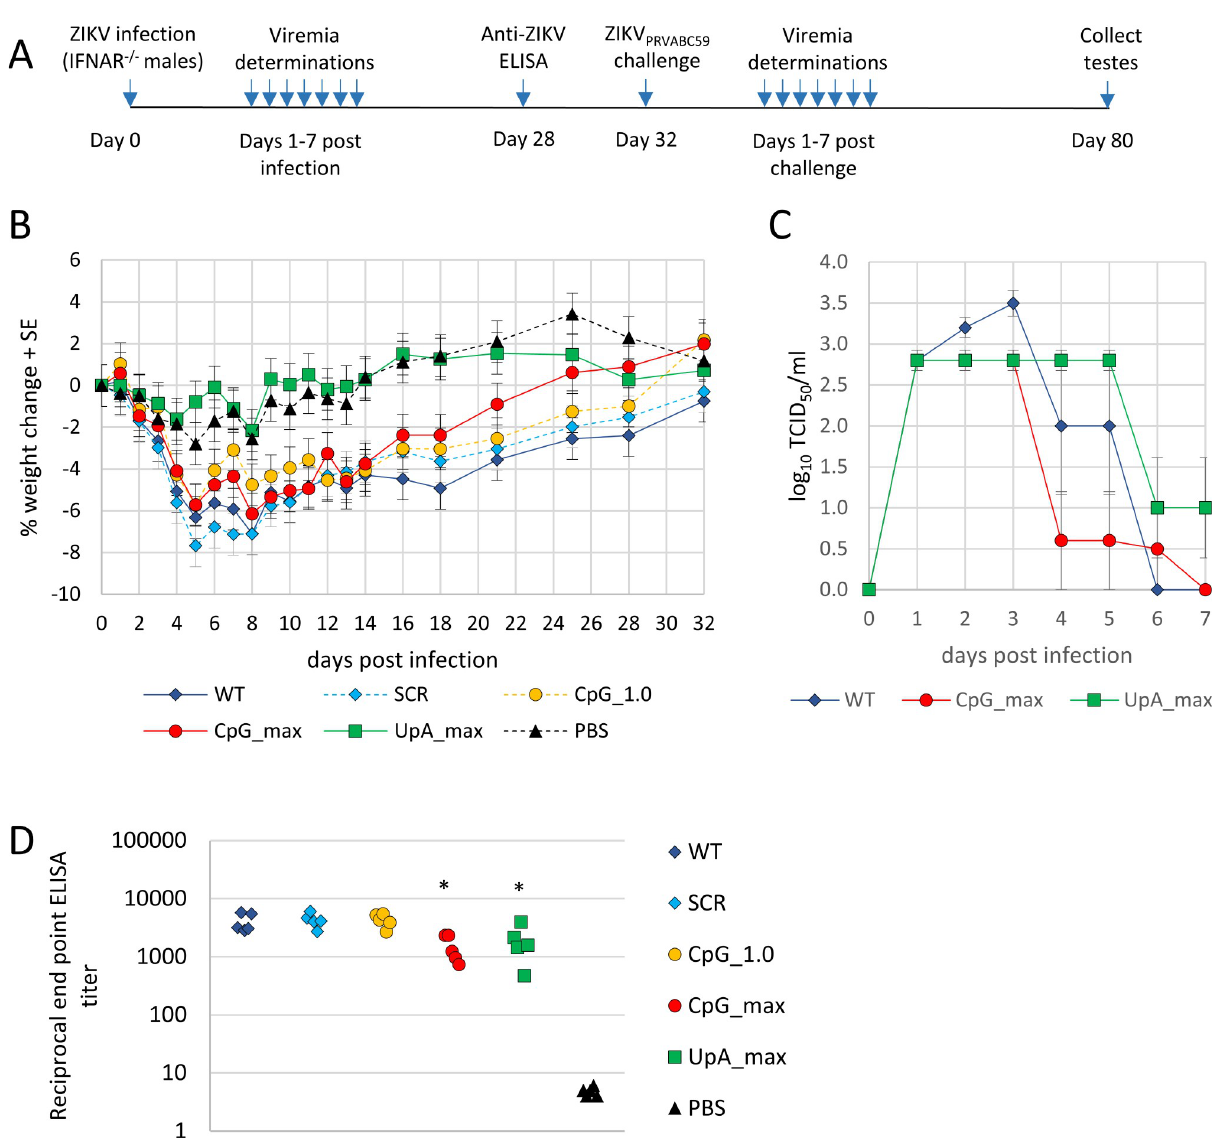
Fig 6. Weight loss, viremia, and ZIKV antibody responses postprimary ZIKV infection. (A) Timeline of experiment. (B) Weight loss of IFNAR − / − mice postinfection ( n = 5 mice per group). (C) Viremia postinfection of mice infected with WT ZIKV or CpG_max or UpA_max ZIKV. (D) 50% End- point of total IgG ELISA titers 4 weeks postvaccination with indicated ZIKV mutants. Significant changes from WT are calculated by a one-way ANOVA with Dunett multiple comparisons test and indicated with asterisks ( p < 0.05). Numerical values for panels B–D are available in S1 Data. IgG, immunoglobulin G; SCR, scrambled control virus; WT, wild-type; ZIKV, Zika virus.